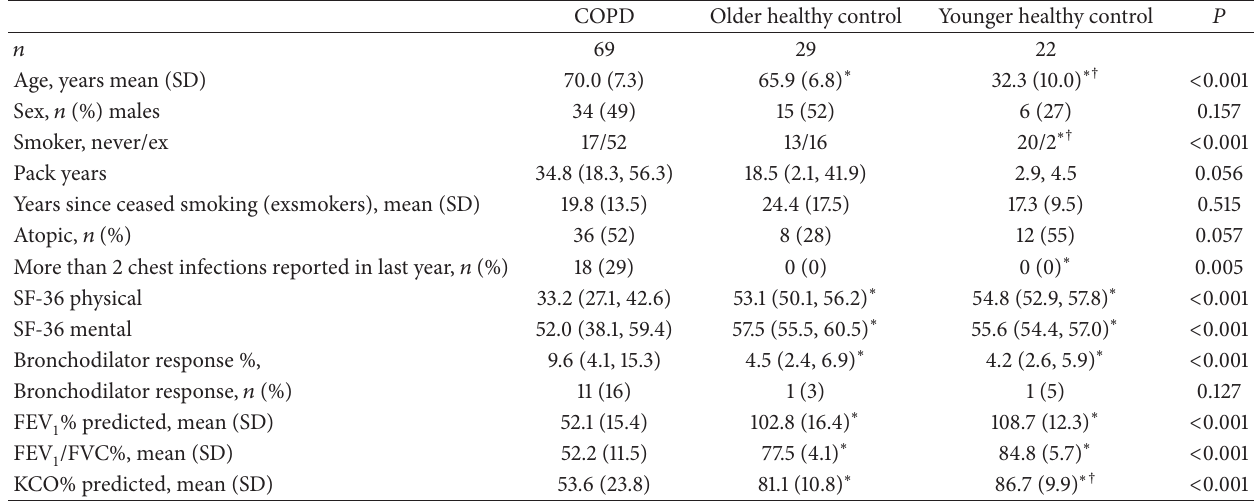
Table 1: Clinical characteristics for all participants. Data are median (q1, q3) unless indicated. COPD